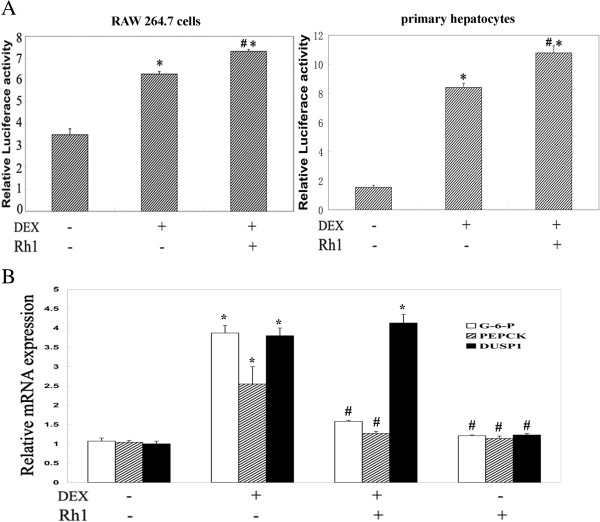
Effect of Rh1 combined with DEX on GRE activity and some gluconeogenesis-related genes. RAW264.7 cells were treated with solvent, DEX alone or Rh1 combined with DEX for 24 h. (A) Cell lysates were assayed for luciferase activities. Promoter activities are expressed as relative induction factor, that is, the ratio of expression levels recorded either at induced and non-induced conditions, with the latter taken to be 1. Assays were performed in triplicate, and results are representative of at least two independent induction experiments. (B) Primary hepatocytes were treated with solvent, DEX alone or Rh1 combined with DEX for 24 h. RNA was isolated and reverse transcribed. The resulting cDNA was subjected to PCR analysis with primers to detect the household gene GAPDH (loading control) or the gene coding for DUSP1, PEPCK and G6P in the same sample. *P <0.01 versus control, #P <0.01 versus DEX group. DEX, dexamethasone; DUSP1, dual specificity protein phosphatase 1; G6P, glucose-6-phosphatase; GRE, glucocorticoid receptor elements; PEPCK, phosphoenolpyruvate carboxykinasee phosphatase; TNF, tumor necrosis factor.